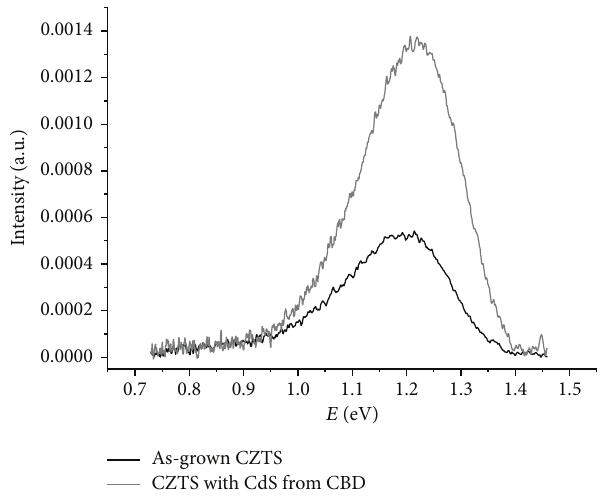
= 402 nm, 𝑃 = 2 W/cm 2 ) of Figure 9: PL spectra at 20K ( 𝜆 exc exc the as-grown CZTS samples after the etching procedure in aqueous HCl (black line) and of CdS/CZTS solar cells (grey